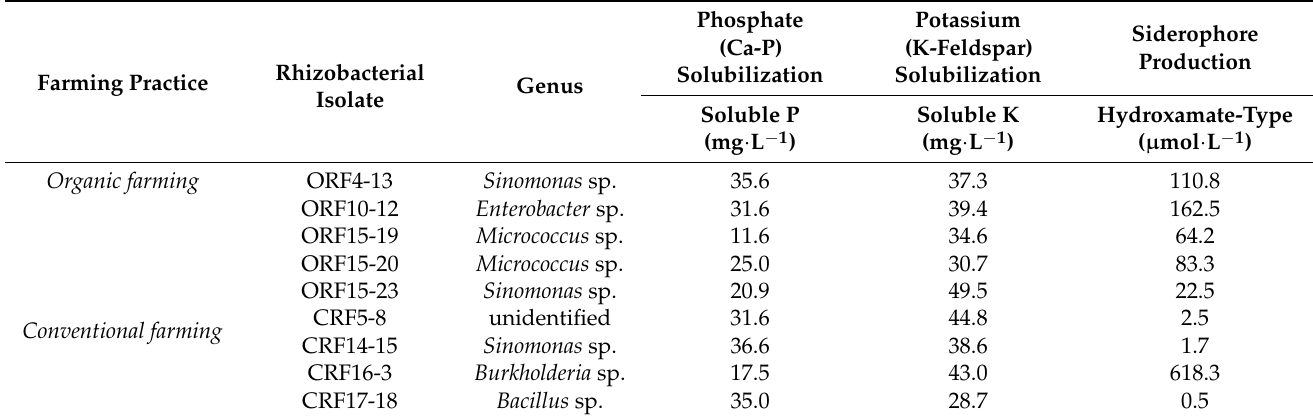
Table 1. Phosphate and potassium solubilization, as well as siderophore production, by the nine selected KDML105 rice rhizobacterial